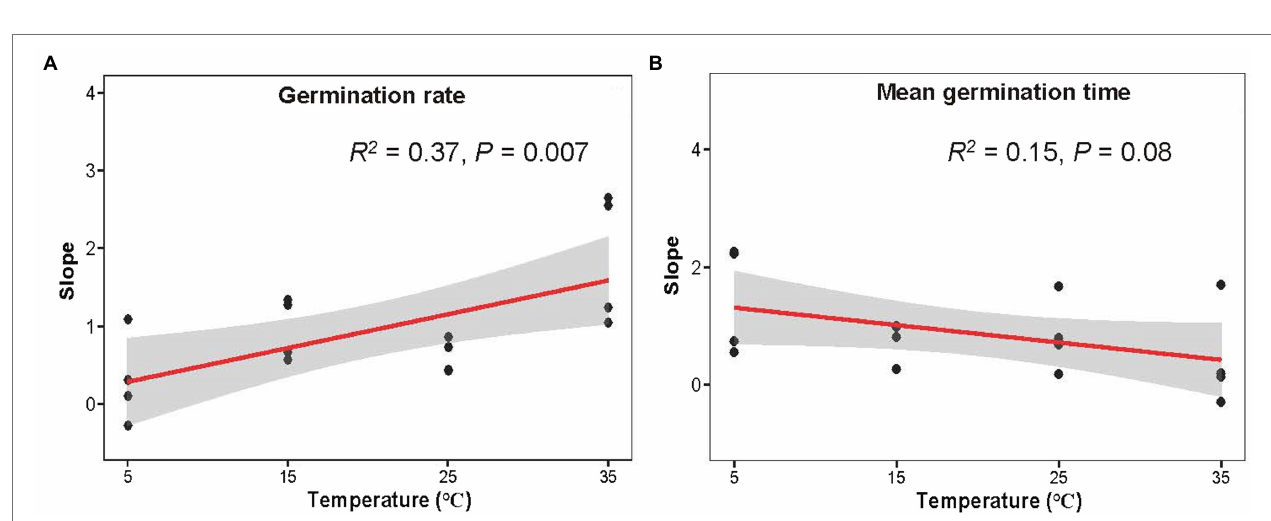
FIGURE 5 | Variation of germination rate (A) and mean germination time slopes (B) of latitude influence of 0/1/3/5-month-stratification Spartina alterniflora seeds under different temperatures (shaded area indicates 95% CI). Slope was from Figure 4